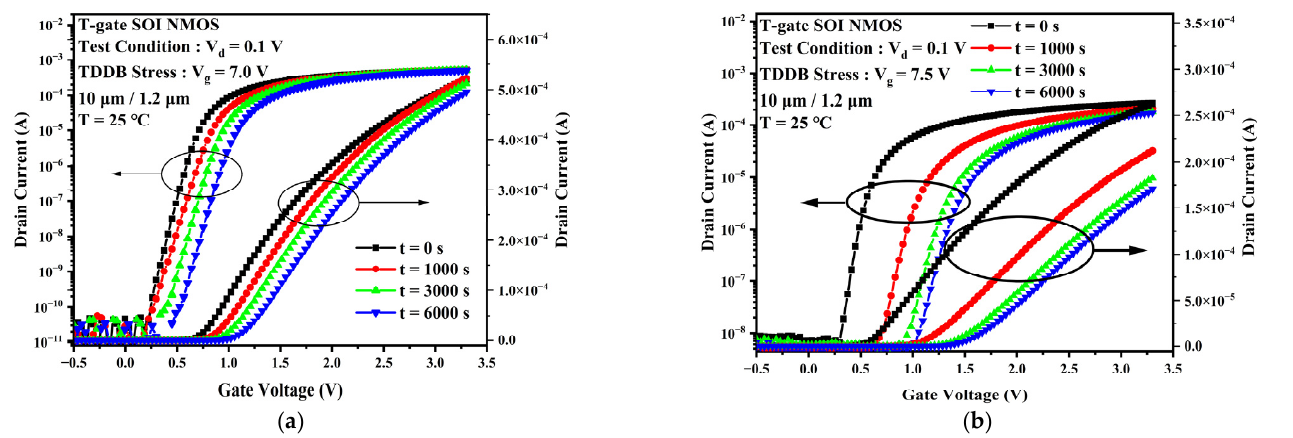
Figure 3. Degradation of the device threshold voltage when the TDDB stress is applied.